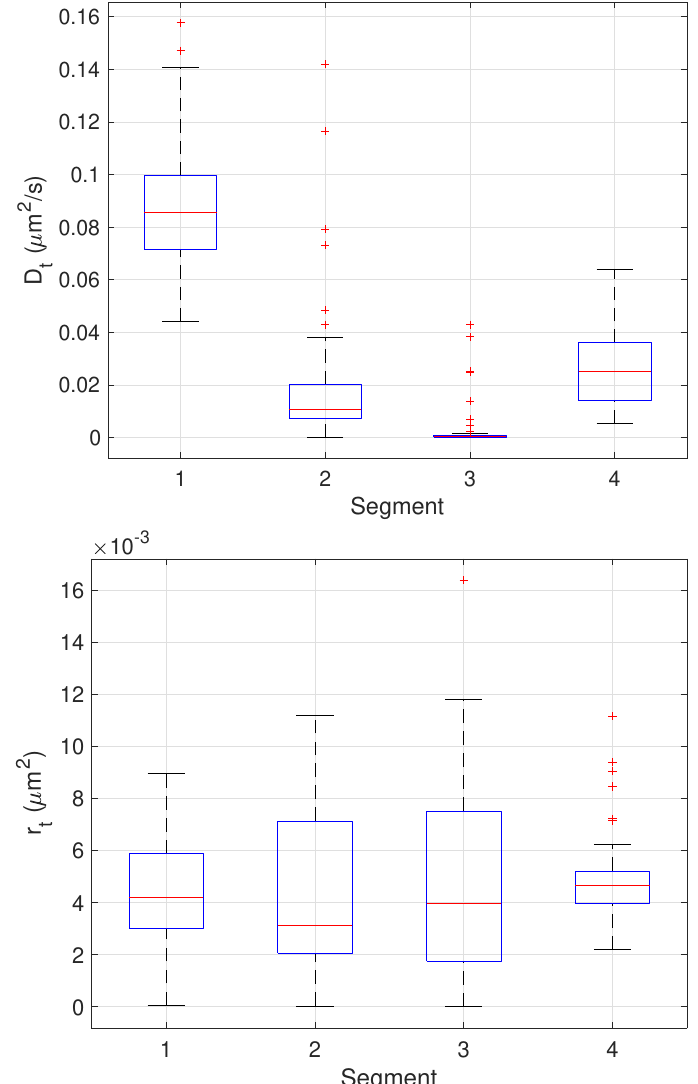
Figure 13. Box plots showing median, center two quartiles, and outliers for the estimates of the model parameters in each segment for the 64 trajectories